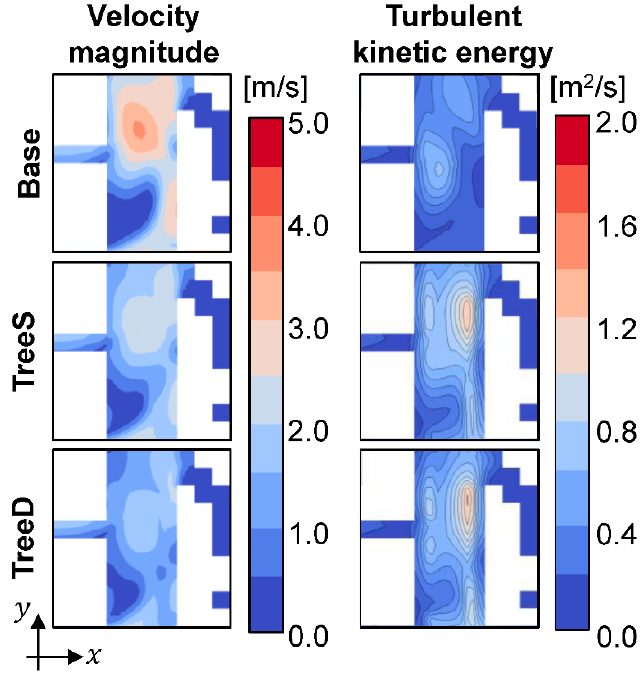
Figure 9. Wind velocity magnitude and distributions of TKE at 12:00 at 3.0 m height for each case.